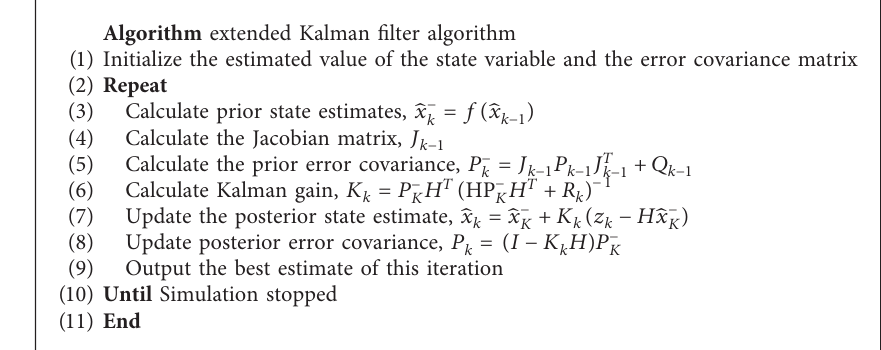
Algorithm extended Kalman filter algorithm